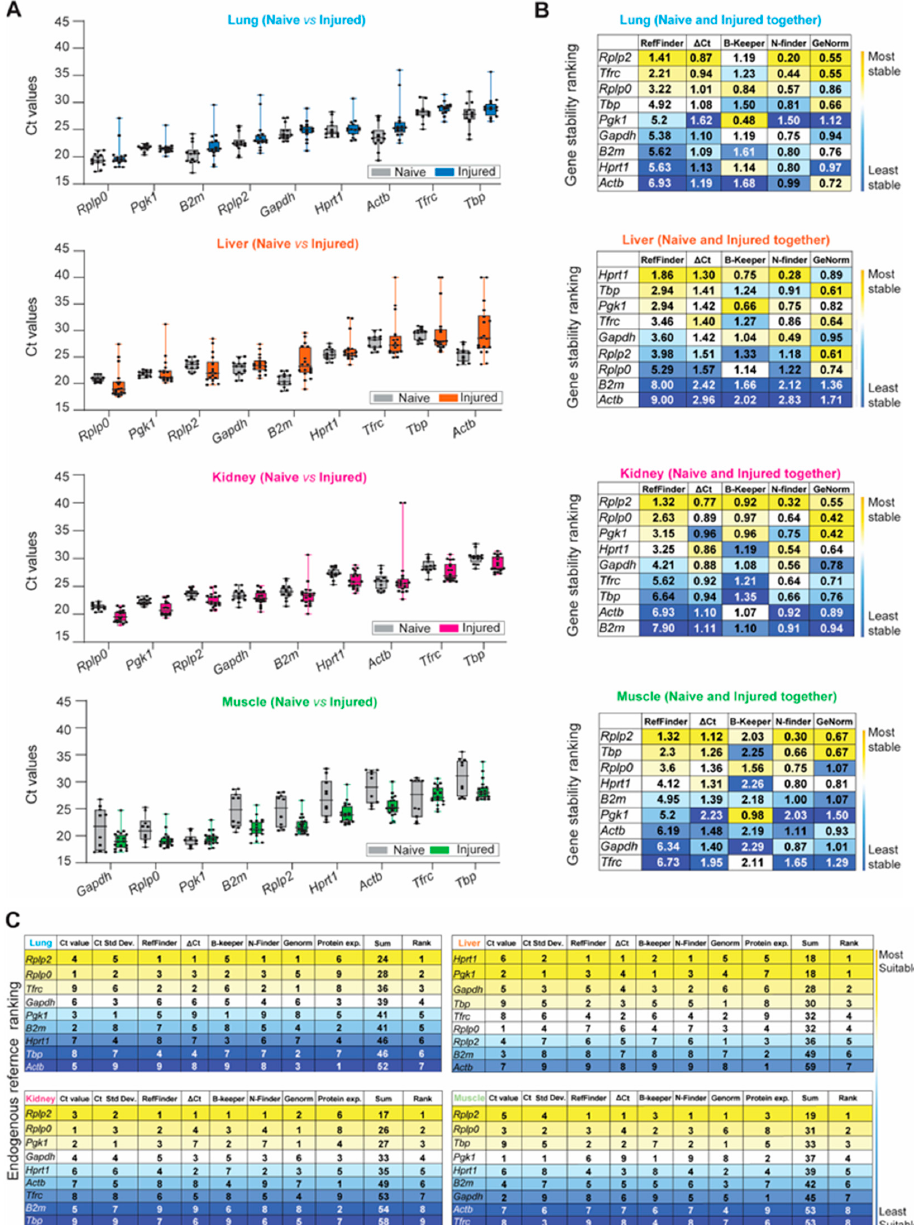
Figure 4. Identification of the most suitable endogenous reference in different experimental conditions (naïve and injured tissue) of the lung, liver, kidney, and muscle. ( A ) Ascending order distribution of the Ct values for the nine HKGs in the steady-state (naïve, grey) and injured tissues (injured, colored) (n ≥ 10 rats). Error bars represent the standard deviation of the mean. ( B ) Heatmaps representing the gene stability rankings obtained with RefFinder, Delta Ct ( Δ Ct), BestKeeper (B-Keeper), NormFinder (N-finder), and GeNorm for the nine HKGs by combining the data from the naïve and all timepoints. The color scale represents the most stable gene (yellow) to the least stable gene (blue), (n ≥ 27 rats). ( C ) Ranking of the nine HKGs according to Ct value, Ct value standard deviation, gene stability from the five algorithms including naïve and injured tissues, and protein expression level in naïve tissues. The color scale represents the most (yellow) to least (blue) suitable endogenous reference gene.